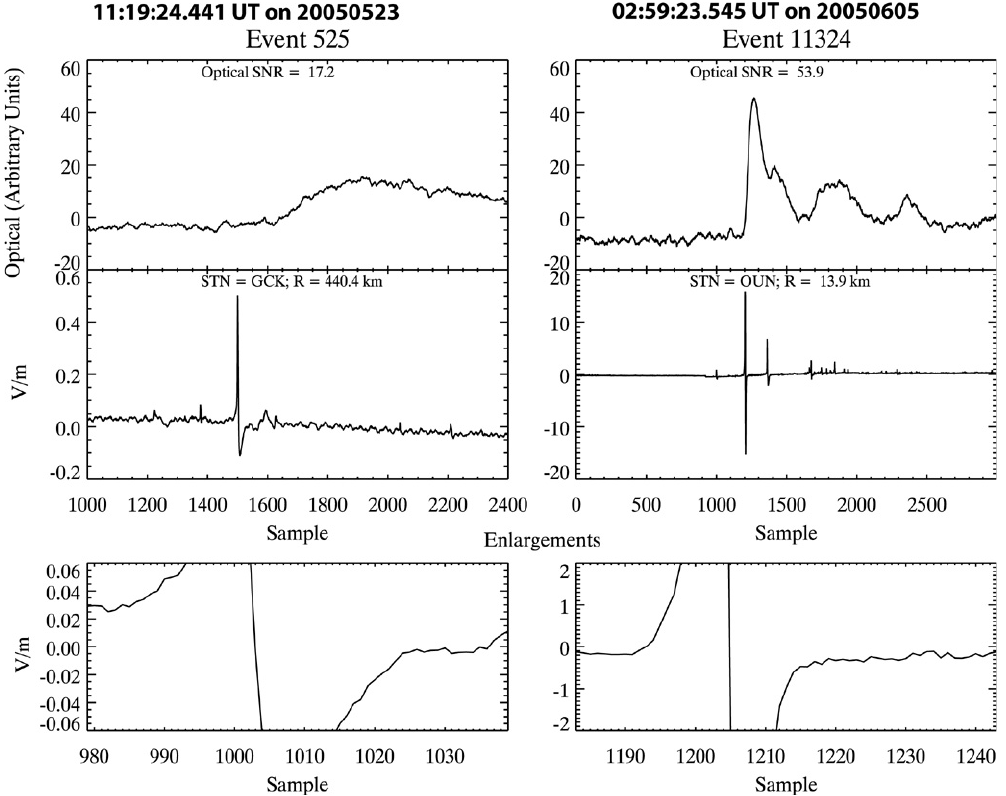
Fig. 16. The two + NB events that appear to show optical emission. The top panels are the optical recordings coincident with the sferic triggers. The middle panels are the sferic recordings themselves. The bottom panels are closeups in both ordinate and abscissa on the main NBE pulse, showing slow rise-times ( > 10µs). Note that for one event we show the sferic data from the closest station (in Oklahoma City) to the optical sensor. The reason is that we wish to highlight the additional radio disturbances prior to the main NB pulse. For both event 525 and event 11324, there are significant sferic features starting before both the main NB pulse and that pulse’s ionospheric